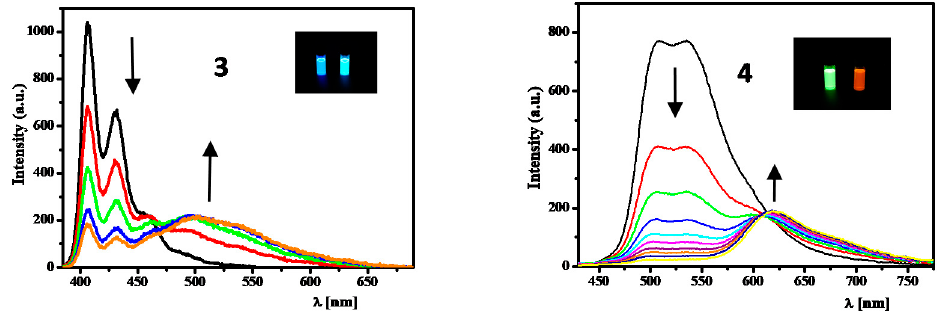
Figure 12. Emission spectra of dichloromethane solutions of 3 and 4 (c = 5µM) titrated with TFA at a concentrations of 0, 20, 40, 60 and 80 mM for 3 and 0, 20, 40, 60, 80, 100, 120, 140 and 160 mM for 4 (excitation at 376 nm for 3 and 400 nm for 4 ). Insets show the emission colors, under UV light, in the absence of TFA and in the presence of excess TFA (left and right,